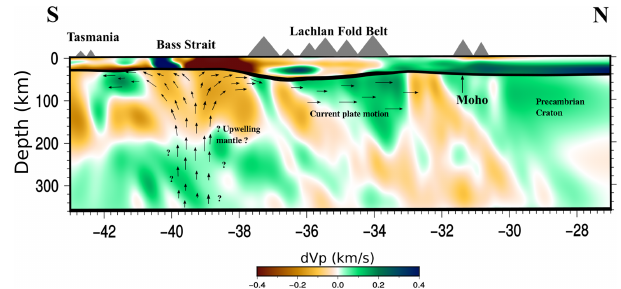
Figure 12. Composite result of teleseismic tomography (mantle ve- locity anomalies), ambient noise (crustal velocity anomalies), re- ceiver functions (Moho), and shear wave splitting (inferred man- tle flow relative to over-riding plate). Velocity slices are taken at 148 ◦ E. Note that the crustal model produced from ambient noise tomography is defined in terms of V sv , but it was converted to V p in the study of Bello et al. (2019b) to permit its inclusion in the starting model for the inversion of teleseismic P -wave arrival time residuals. In this figure, the crustal V p anomalies are